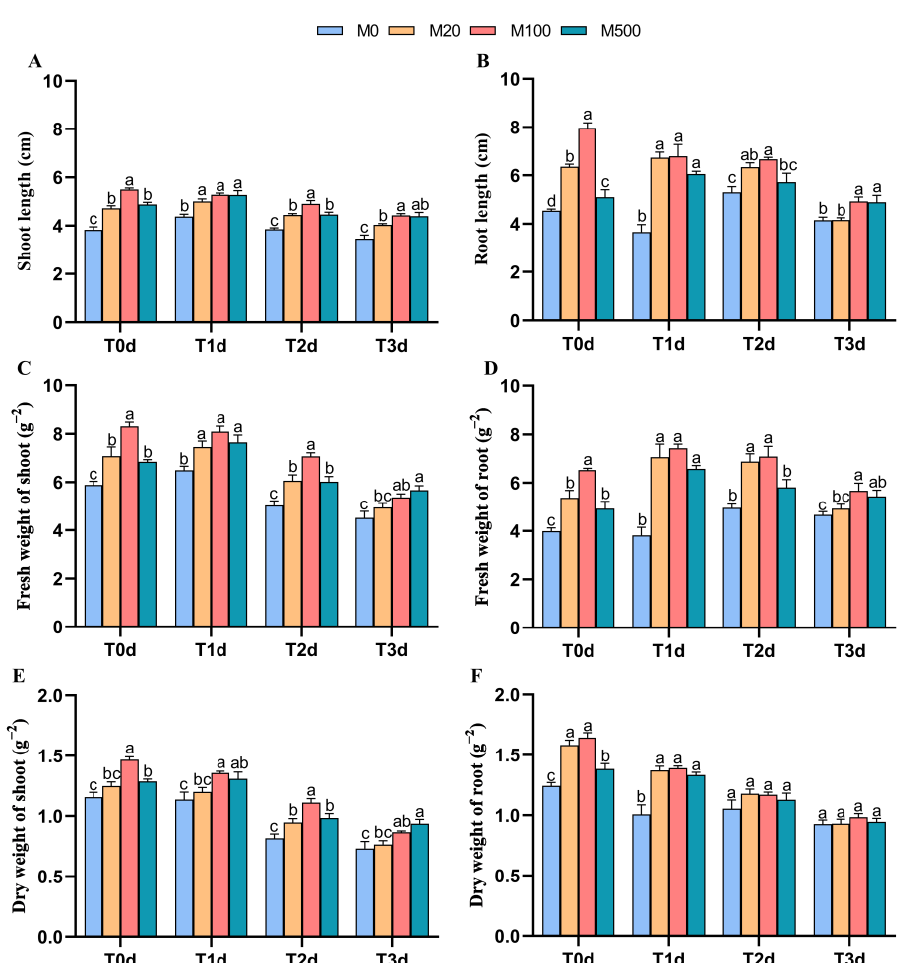
Figure 2. Effects of melatonin and flooding stress on shoot lengths ( A ), root lengths ( B ), fresh weight of shoots ( C ), fresh weight of roots ( D ), dry weight of shoots ( E ), and dry weight of roots ( F ). Different letters represent statistically significant differences ( p < 0.05).